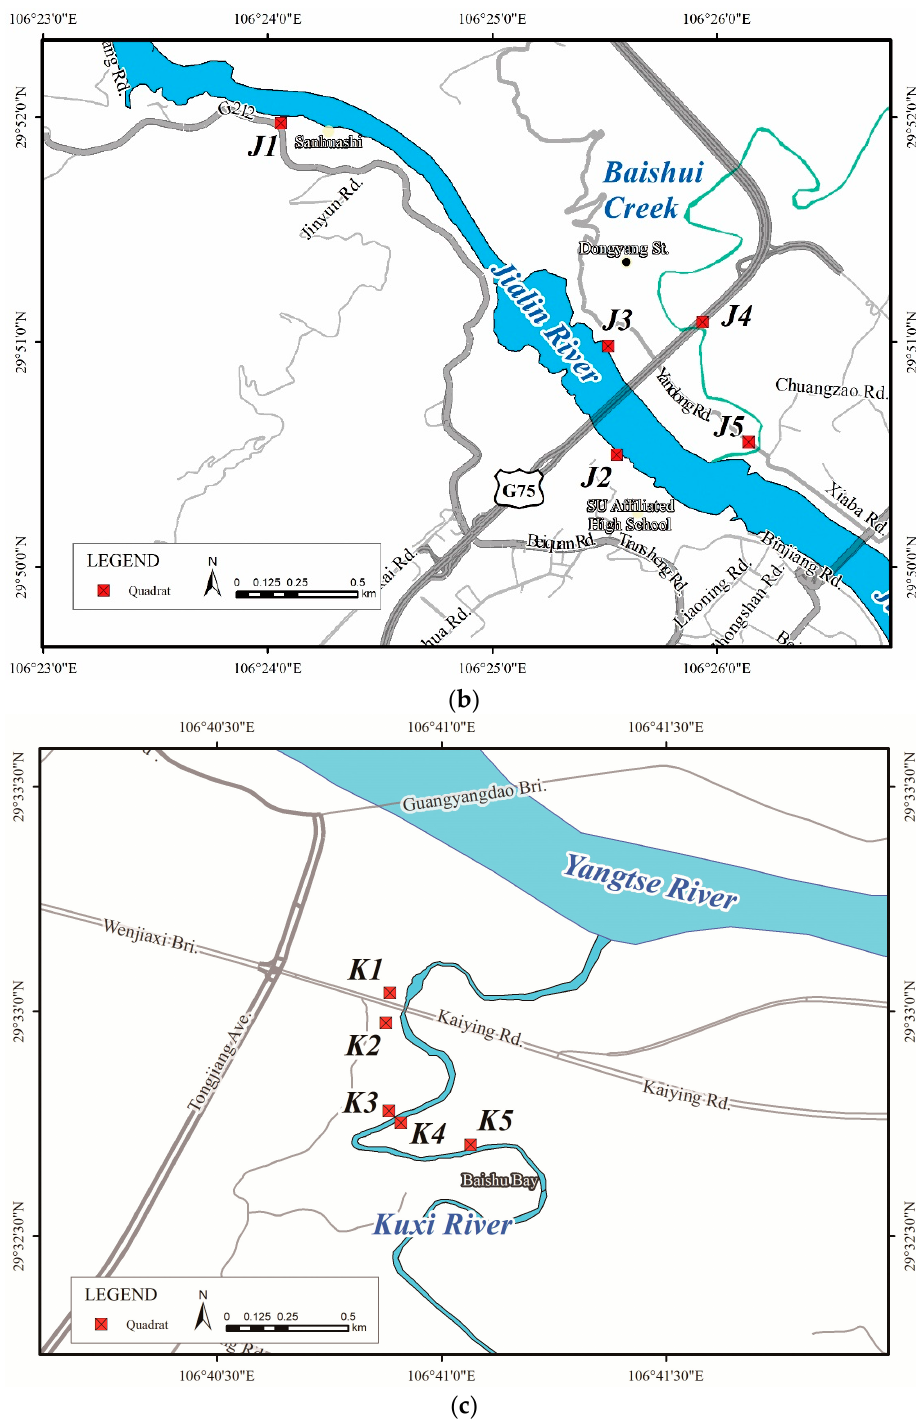
Figure 1. ( a-1 , a-2 , b , c ) The locations of the sampling sites along: ( a ) the Jialing River, ( b ) the Yulin River and ( c ) the Kuxi River in Chongqing, China. The map was drawn by Danrong Wan.